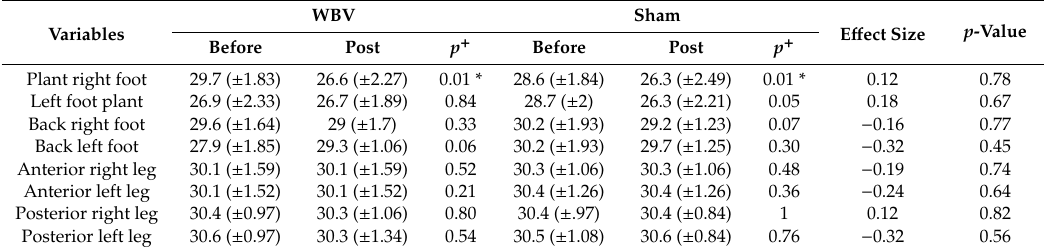
Table 2. Mean skin temperature analysis in ◦ C (and standard deviation) before and after intervention (intra- and intergroup) and e ff ect size.